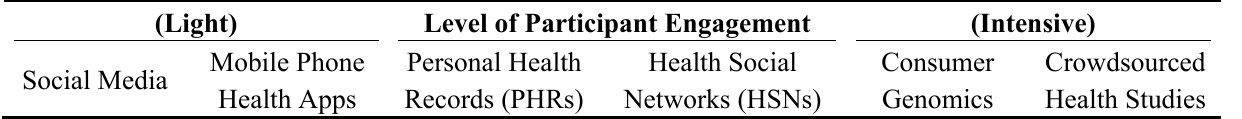
Table 2. Participatory health activities ranging from light to intensive